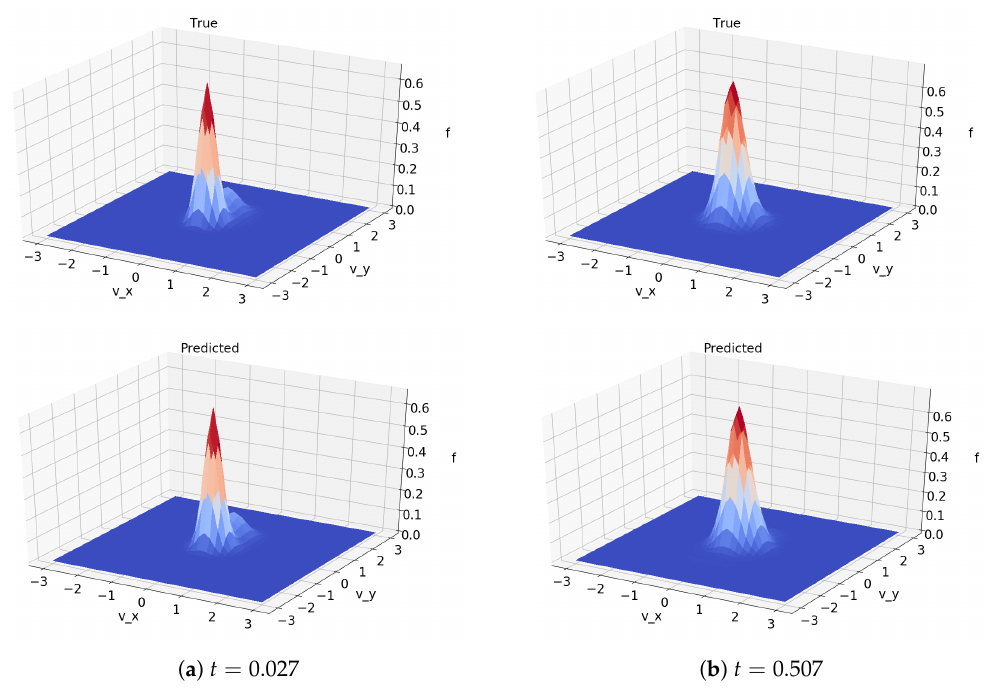
Figure 6. Comparison between solutions computed numerically ( top ) and using the machine learned model ( bottom ). Both comparisons were produced from the same initial data. Time stamps are normalized to the maximum time for which training data existed. These plots are of a single slice of the